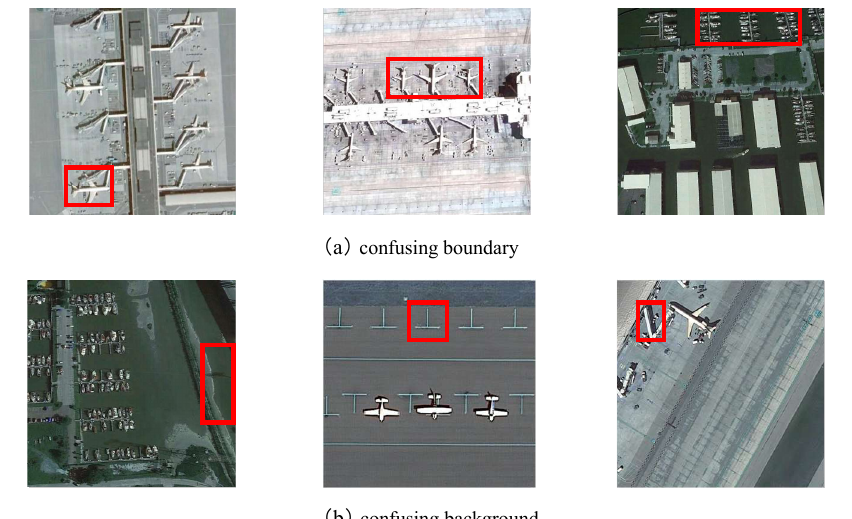
Figure 1. WSOD issues in remote sensing images: ( a ) confusing boundary: less tight candidates or fail to differentiate clustered instances (top); ( b ) confusing backgrounds: misjudge the background as object